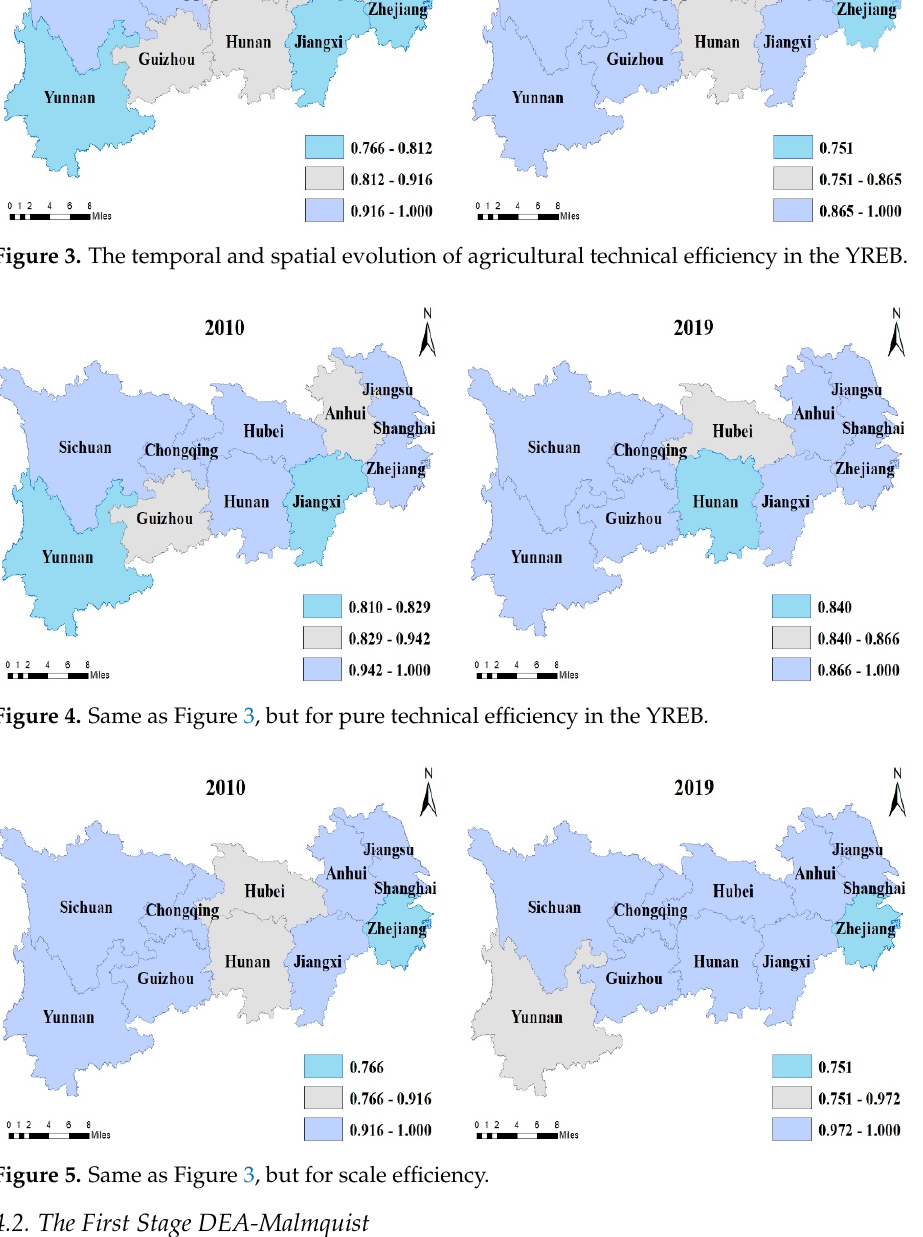
Figure 5. Same as Figure 3, but for scale efficiency.